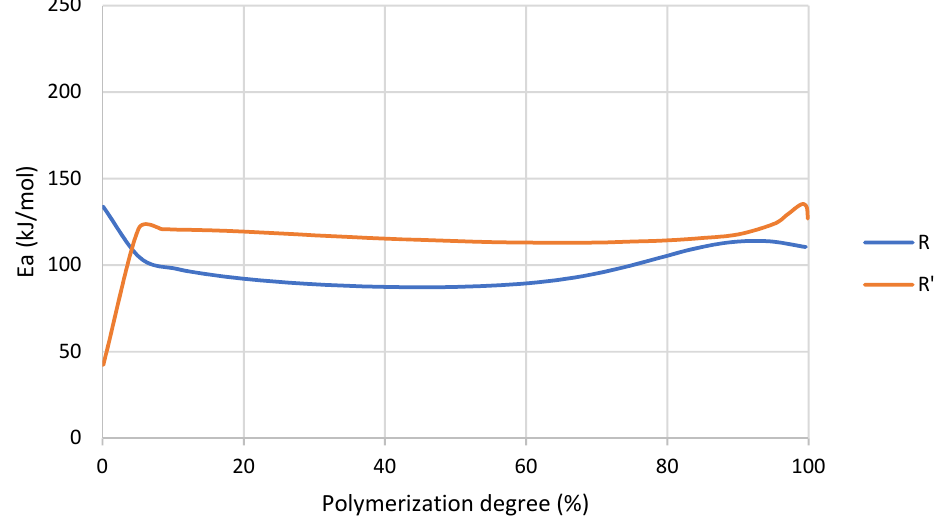
Figure 6. Activation energy as a function of conversion degree of R and R’ obtained by MFK model.